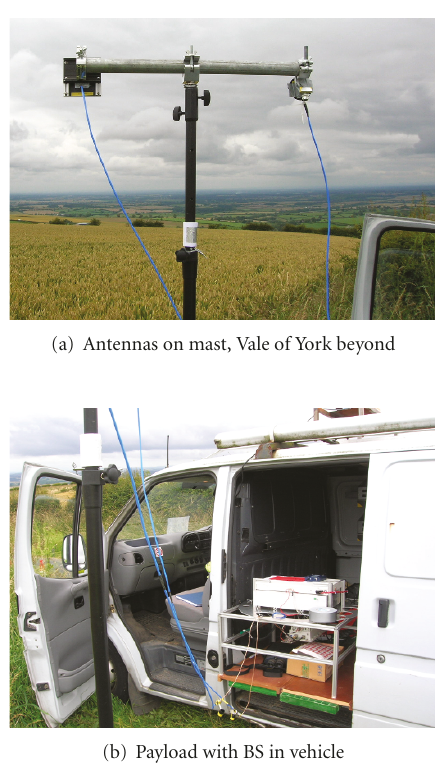
modulation levels shown in Table 2) for both UL and DL.